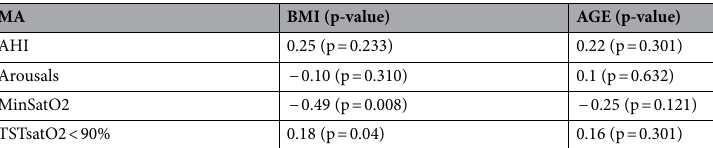
Table 6. Pearson’s correlation (MA) between BMI and AGE with AHI, arousals, minimum O2 saturation and total sleep time with < 90% O2 saturation. N = 23; AHI: Apnea Hypopnea Index; Min SatO2: minimum saturation of O2); TST SatO2 < 90%: total sleep time with saturation of O2 below 90%.